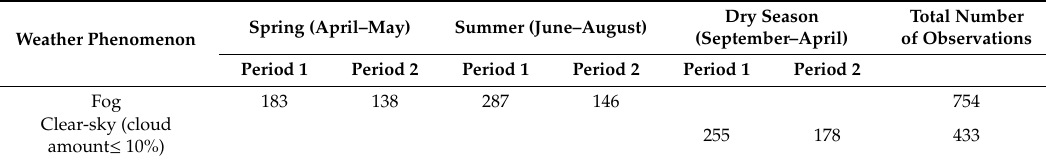
Figure 2. Locations of the 45 meteorological stations in South Korea used for the LSF analysis. Table 2. Ground-based fog and clear-sky observations used to validate the probability index (PI) for the LSF detection at dawn at 45 meteorological stations in South